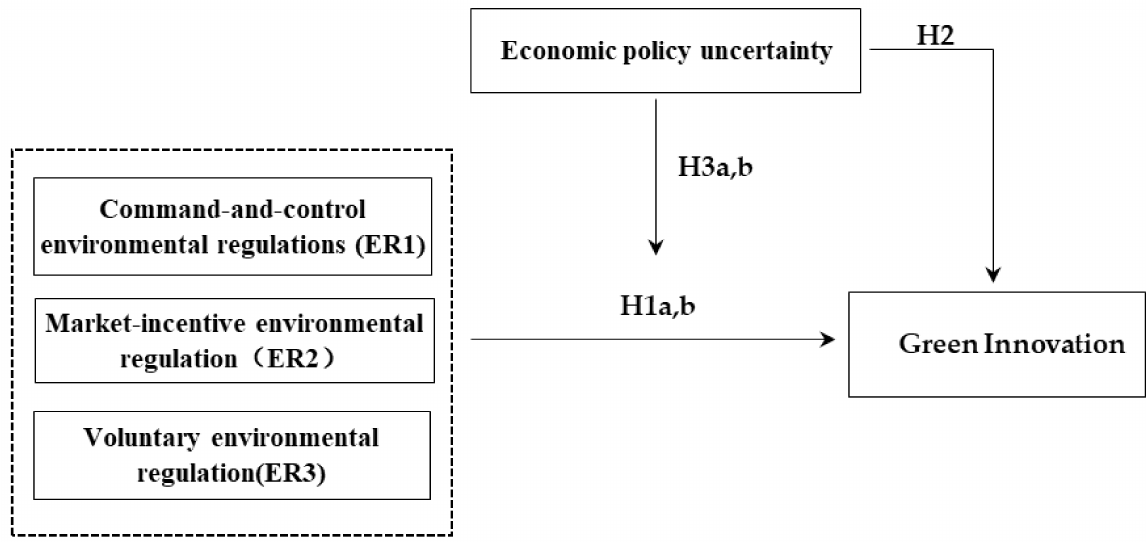
Figure 1. Research